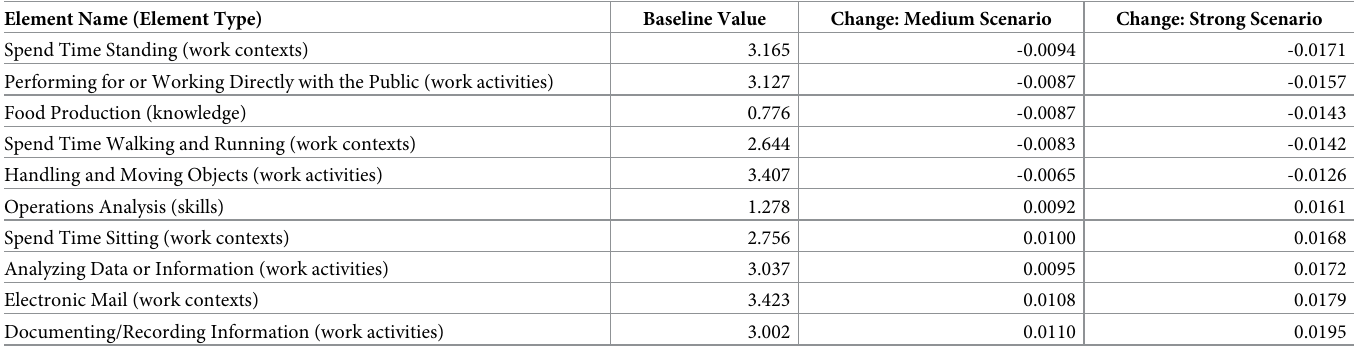
Table 1. Projected changes in importance of occupational